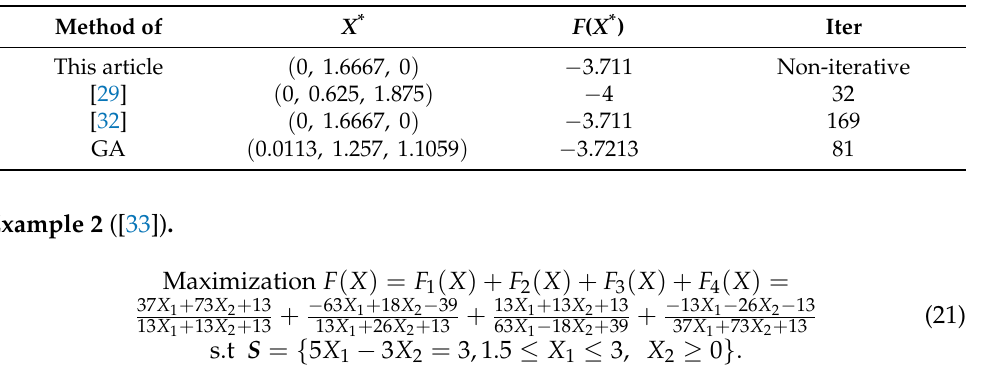
Table 2. Optimal solution and optimal value for (19) obtained by different methods.